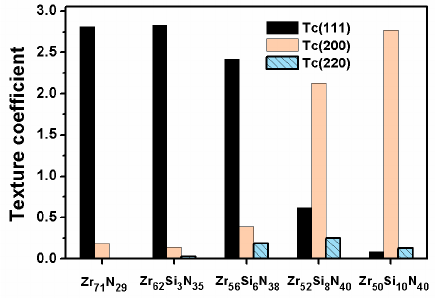
Figure 7. Texture coefficients of Zr–Si–N films with various Si contents.